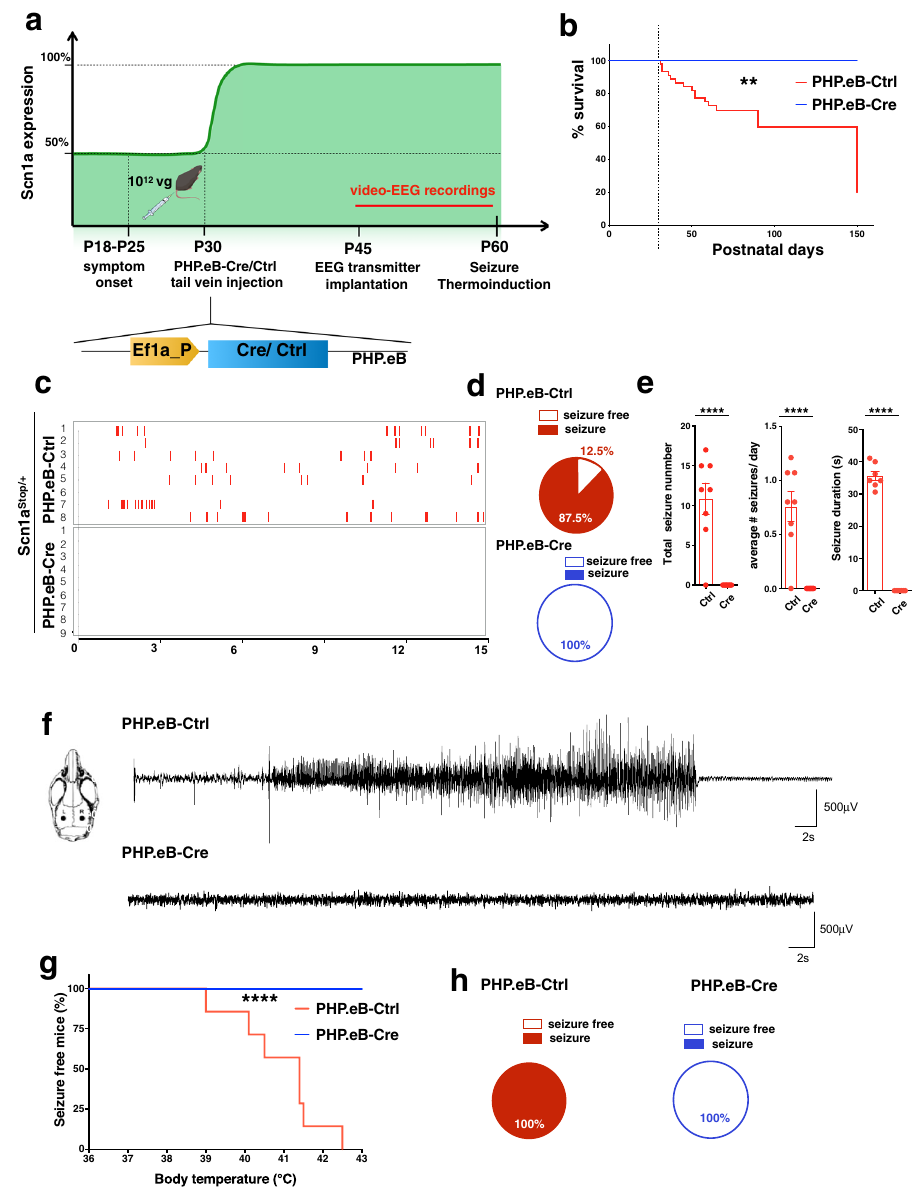
Fig. 3 Re-expression of Scn1a gene after symptoms onset rescues seizures in DS mice. a Schematics depicting the experimental timeline, with Scn1a Stop/ + mice undergoing PHP.eB-Ctrl or PHP.eB-Cre tail vein injection at P30, followed by EEG transmitter implantation at P45, two weeks of EEG recordings and, seizure thermal induction at P60. Created with BioRender.com. b Survival of Scn1a Stop/ + ( n = 23), Scn1a Stop/ + -Cre ( n = 11) monitored out to 90 days (** p = 0.0018; Log-rank Mantel-Cox test). c Raster plot showing all generalized tonic-clonic seizures (Racine scale stages 4 and 5) in 8 Scn1a Stop/ + -Ctrl injected mice and 9 Scn1a Stop/ + -Cre mice subjected to video-EEG recordings. d Pie chart (right panel) showing the proportion of Ctrl- and PHP.eB-Cre- injected Scn1a Stop/ + mice with or without spontaneous seizures ( p = 0.0004; Fisher ’ s exact test). e Cumulative seizure number ( left ), average daily seizure frequency in two weeks of recordings ( middle ) and average seizure duration ( right ), in Scn1a Stop/ + -Ctrl ( n = 8) and -Cre ( n = 9) injected mice. (**** p < 0.0001, two-tailed unpaired test). Data are shown as mean ± SEM, with dots representing individual mice. f Left , schematic of electrode placement in left (L) and right (R) cortical hemispheres for EEG recordings (from bregma AP -1; ML ± 1). Right , Representative traces of EEG recordings of Scn1a Stop/ + -Ctrl injected during an ictal episode and Scn1a Stop/ + -Cre injected. g Percentage of Scn1a Stop/ + -Ctrl and Scn1a Stop/ + -Cre mice remaining seizure-free after thermal induction ( left ) ( n = 8 Scn1a Stop/ + -Ctrl and n = 9 for for Scn1a Stop/ + -Cre (**** p < 0.0001; Mantel-Cox log-rank test). h Pie charts showing the percentage of Scn1a Stop/ + -Ctrl and for Scn1a Stop/ + -Cre mice with or without induced thermal seizures ( p = 0.0004; two-sided Fisher ’ s exact test). Source data are provided as a Source Data fi